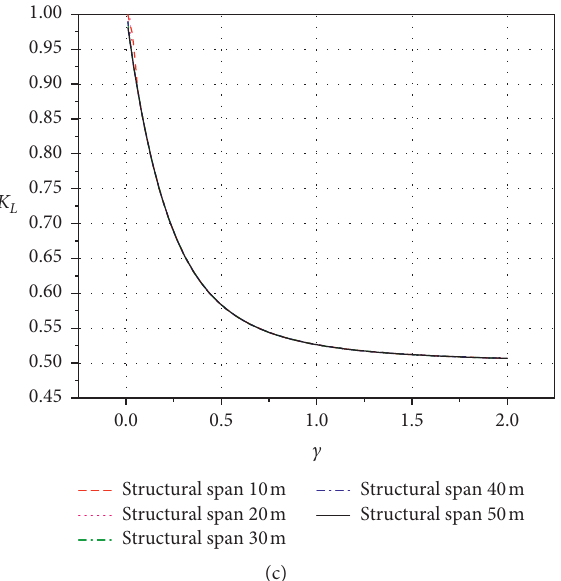
Figure 12: Equivalent load transformation factors of one-way members using Baker’s formula parameters in plastic stage: (a) W � 1kg. (b) W � 10kg. (c) W �